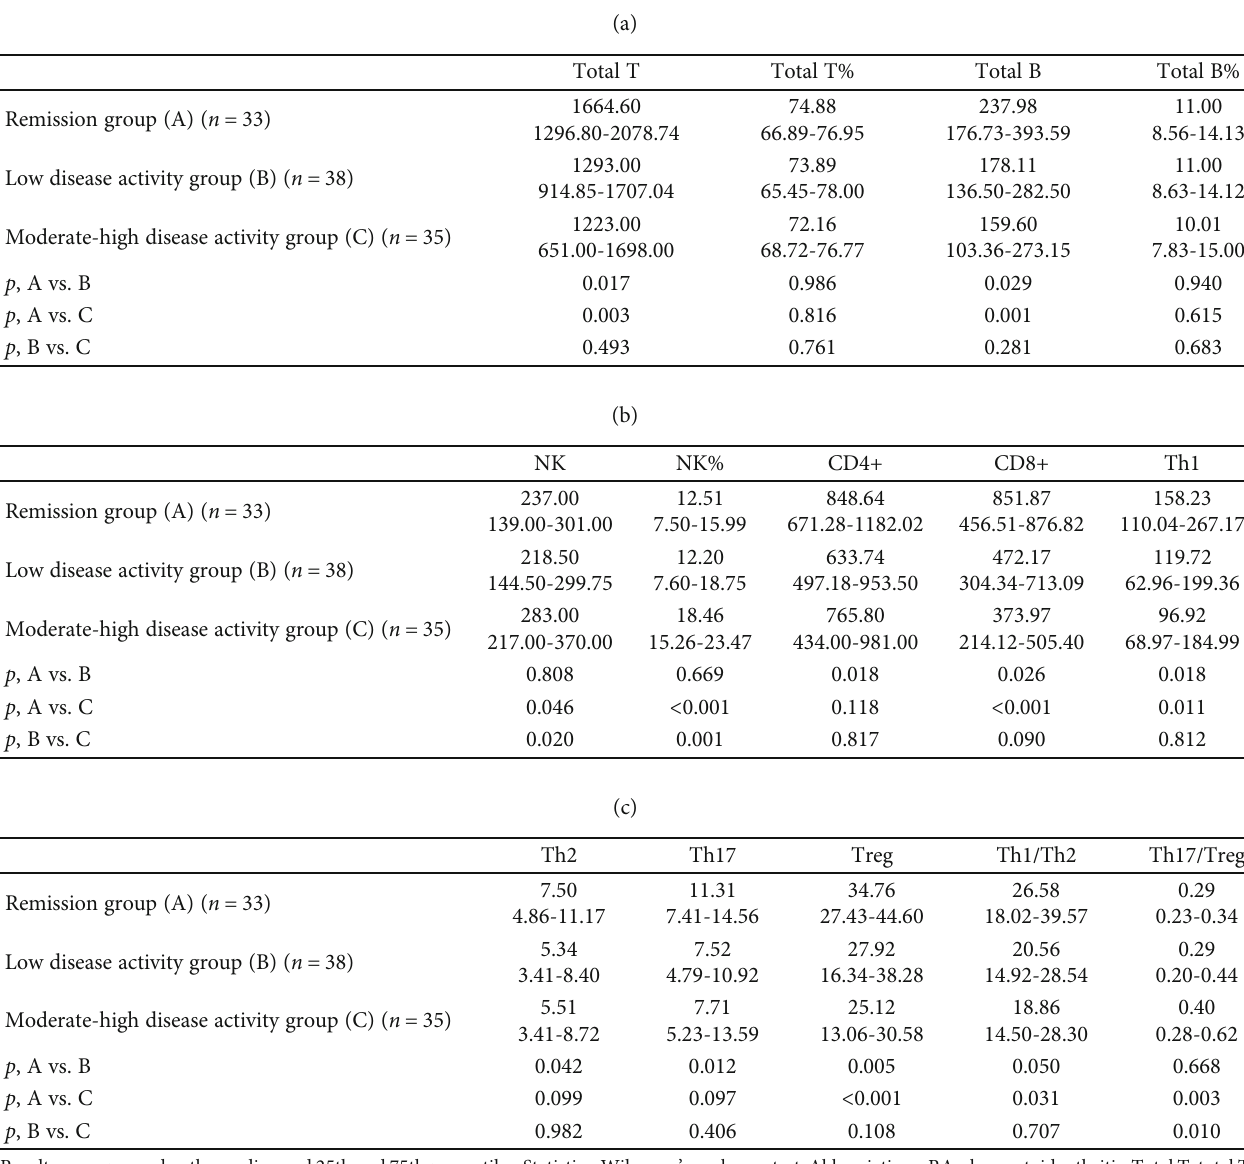
Table 4: Peripheral blood lymphocytes and CD4+ T cells of RA patients in each disease activity